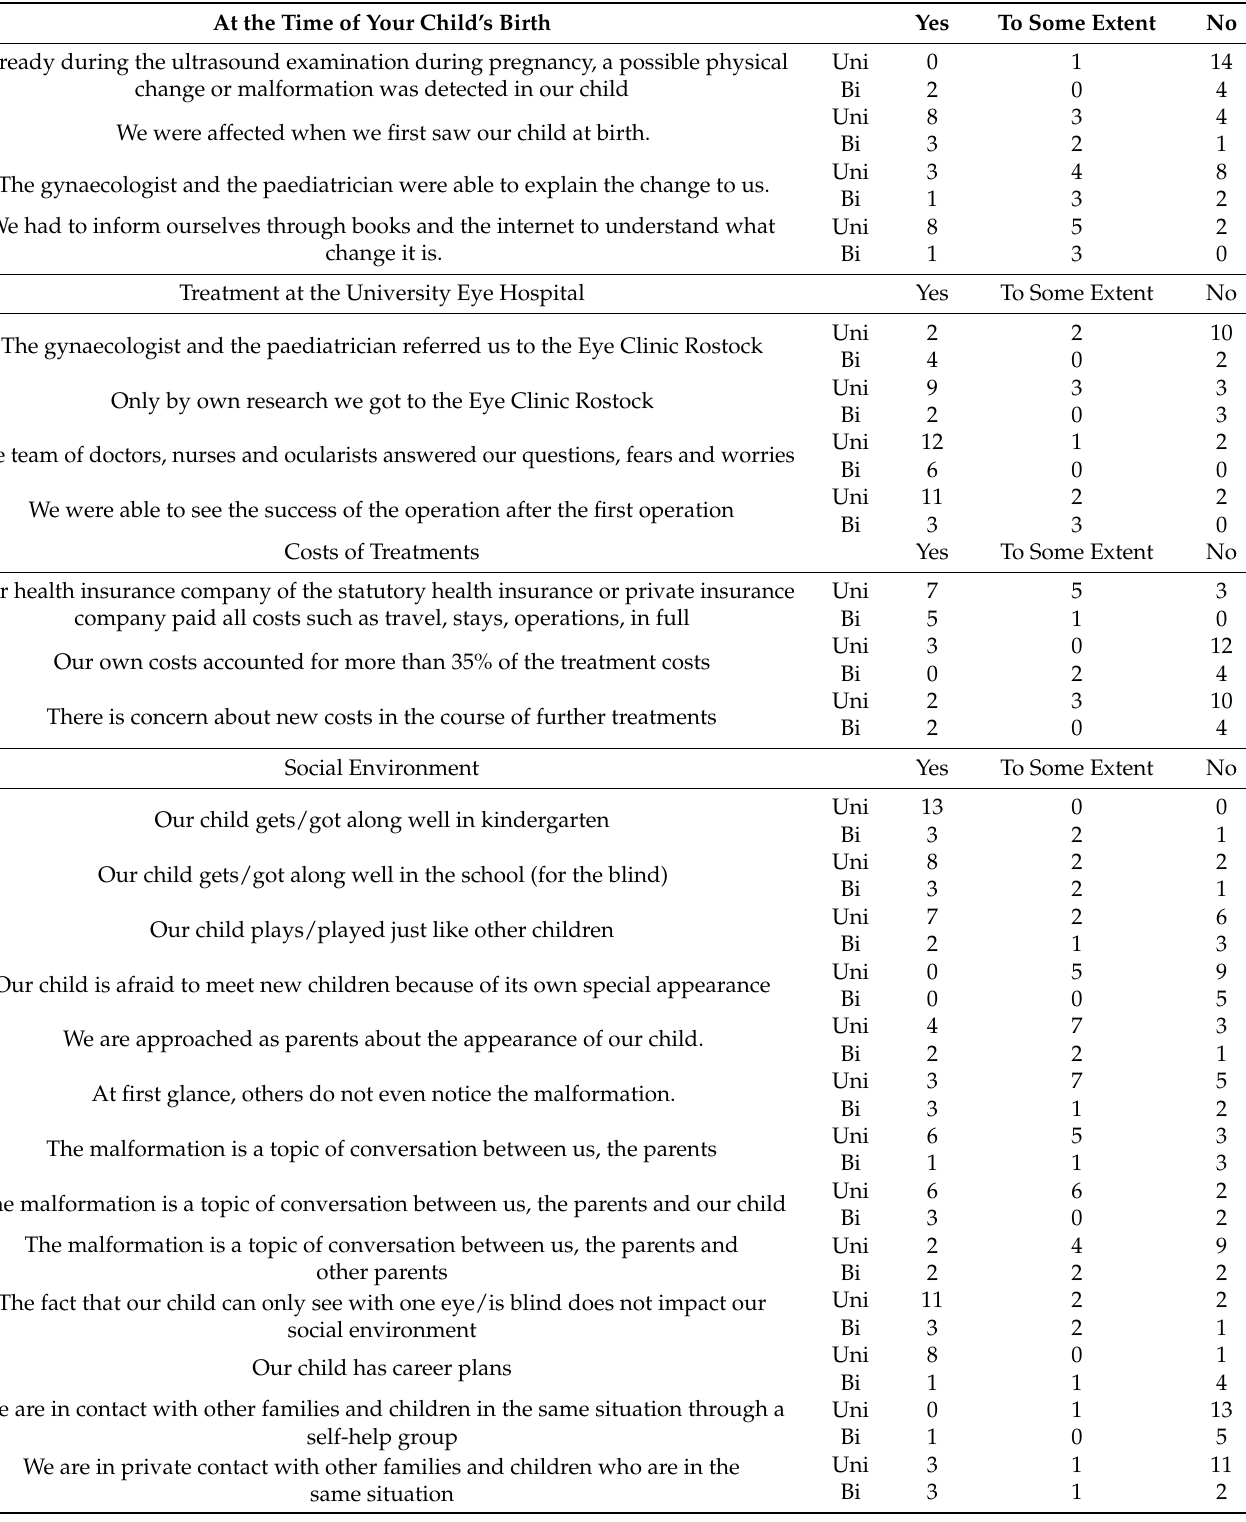
Table 4. Questions and answers of the parent questionnaires of the unilateral anophthalmos and microphthalmos patients (Uni) and bilaterally blind patients